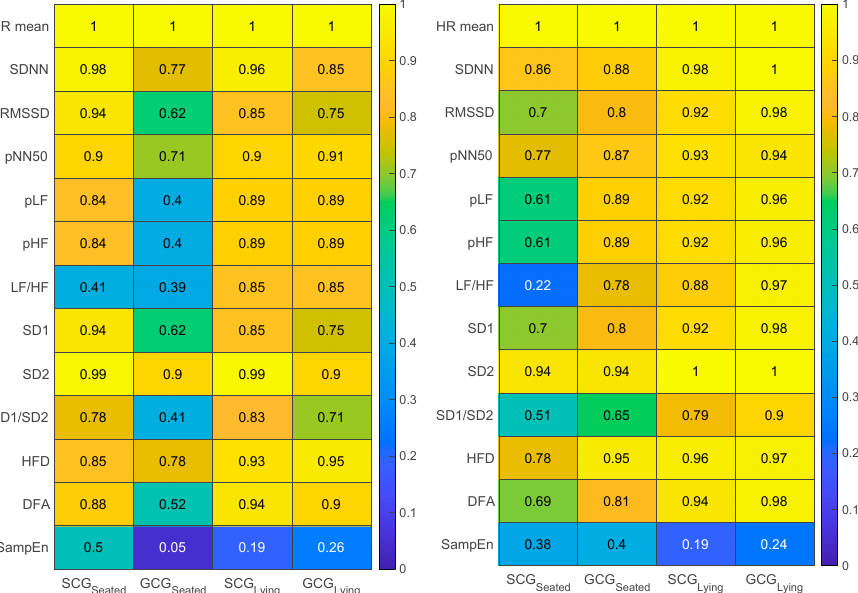
Figure 6. R values (between 0 and 1) obtained in the correlation analysis carried out between values retrieve from SCG and GCG against reference ECG values in both seated and lying position, for both the algorithms.